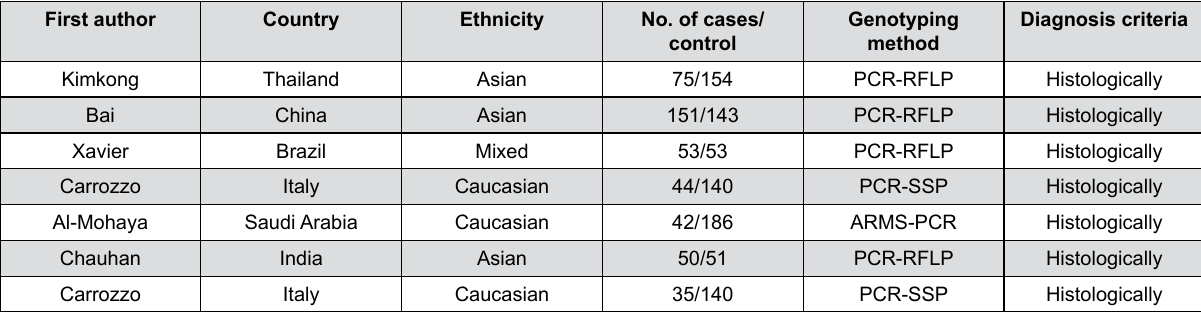
Figure 7- Characteristics of the seven case-control studies included. RFLP: restriction fragment length polymorphisms; SSP: single- specific primer, PCR: polymerase chain reaction; ARMS: Amplification Refractory Mutation